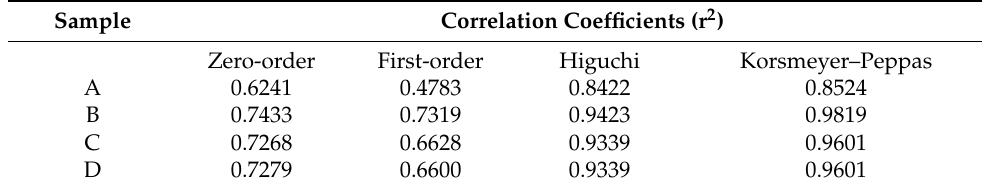
Table 7. Correlation coefficients obtained when experimental data are fitted to different models.